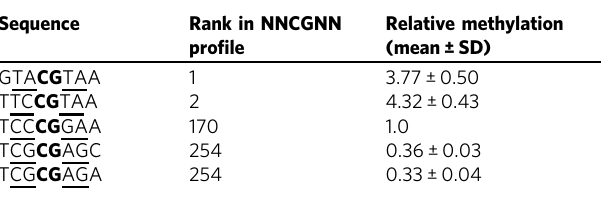
NGS derived fl anking sequence preferences were validated by radioactive DNA methylation kinetics with exemplary substrates. All sequences were embedded in a constant TTGCACTCTCCNNNCGNNNGTCCCAGCTTC fl anking sequence context outside of the ±3 fl anking region and annealed with methylated complementary strand. Substrate preferences of DNMT1 in the deep enzymology experiments are indicated by the rank of the substrate in the NNCGNN pro fi le, where 1 represents the highest preferences and 256 the lowest. Methylation rates are presented as averages and standard deviations of three independent experiments. Representative primary data are show in Supplementary Fig. 4a. The central CpG site is printed in bold letters and the N2 fl anks are